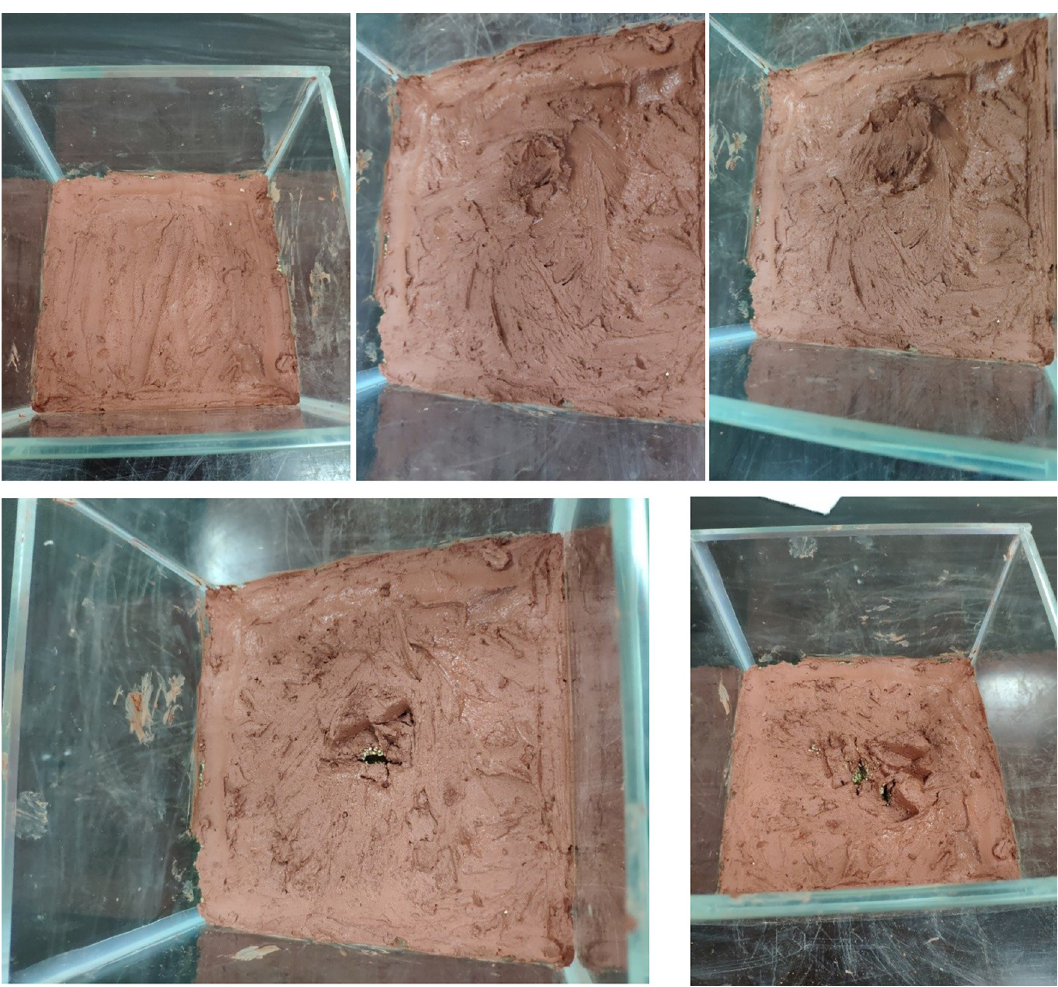
Fig 9. Compression test of mud film of naturally weathered red-bed soil (A) Mud film; (B) Application of 100 N pressure to mud film; (C) Application of 200 N pressure to mud film; (D) Application of 400 N pressure to mud film; (E) Application of 800 N pressure to mud